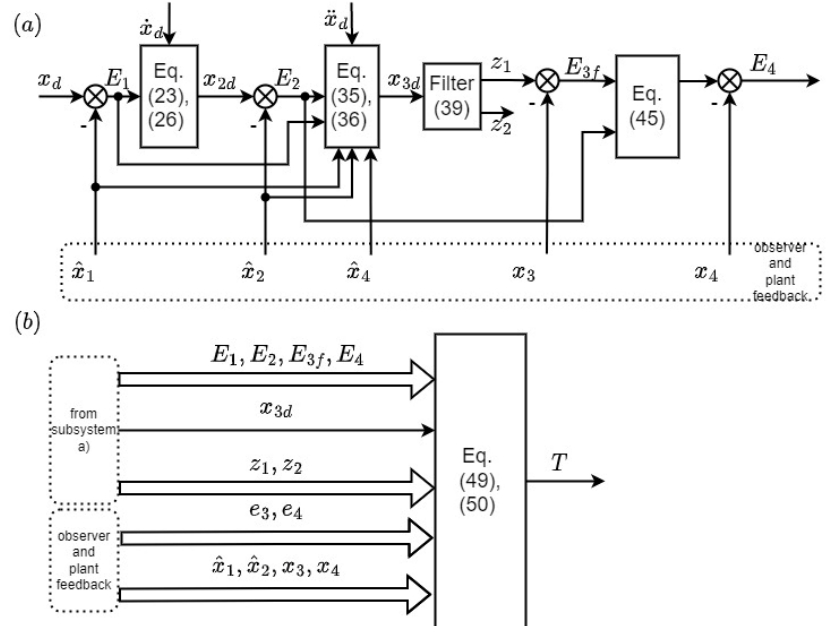
Figure 2. Diagram of the controller: ( a ) preparation of the auxiliary signals, ( b ) the control signal.